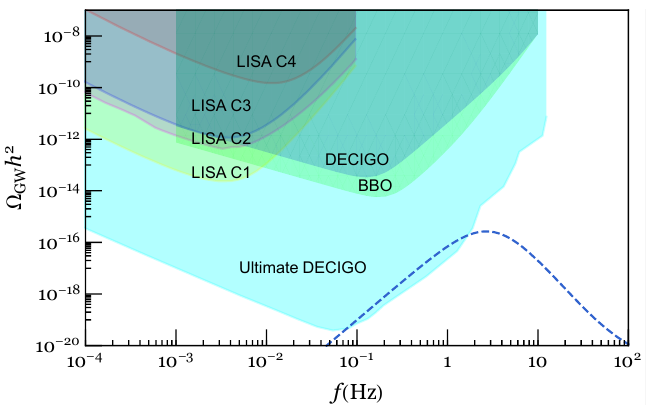
Figure 9 . The generated GW signal for a benchmark point of y N λ R = 0 . 014 , v w = 0 . 48 and v R = 15 TeV (blue dashed). Colored regions are probed by LISA, DECIGO, BBO and